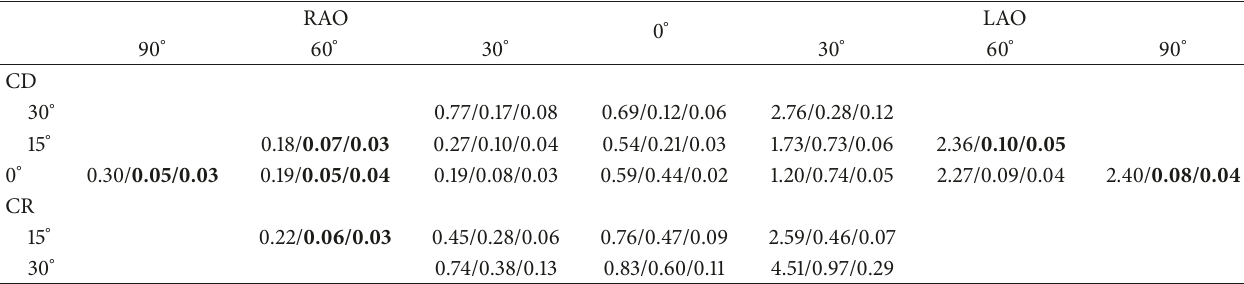
Table1:Doses( 𝜇 Gy)fromscatterradiationper10framesincardiologyfordifferentprojections(ineachcell,dosewithouttheuseofshielding, with shielding placed close to the patient, and with shielding placed close to the physician. Digits in bold do not differ significantly at 0.05.).